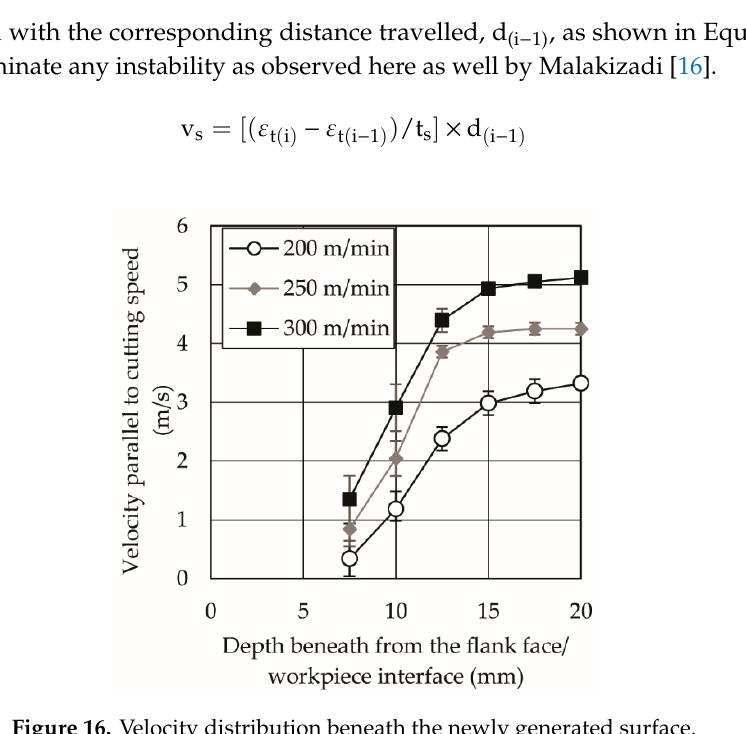
Figure 16. Velocity distribution beneath the newly generated surface. Table 4. Model constants for the calibrated equation based on two boundary conditions.